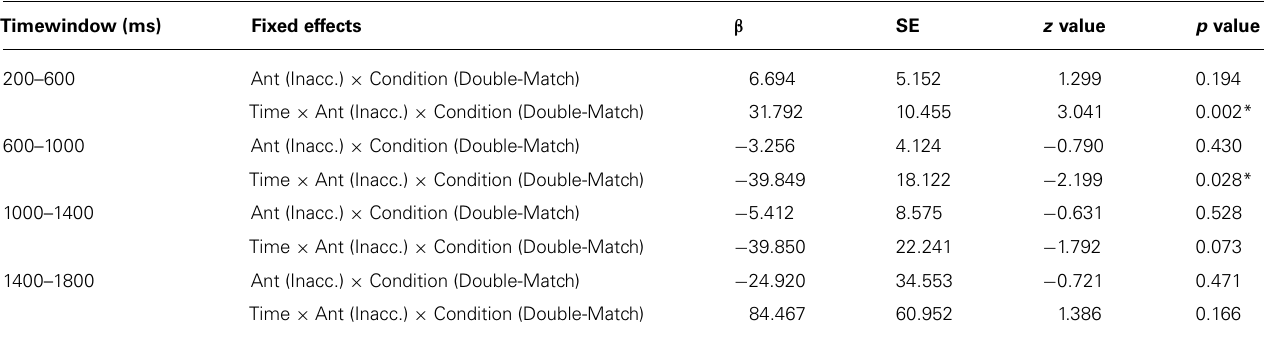
Table 3 |Antecedent × Condition andAntecedent × Condition × Time interactions from best fitting models (full results are shown in AppendixA, found in the Supplementary Material). Timewindow